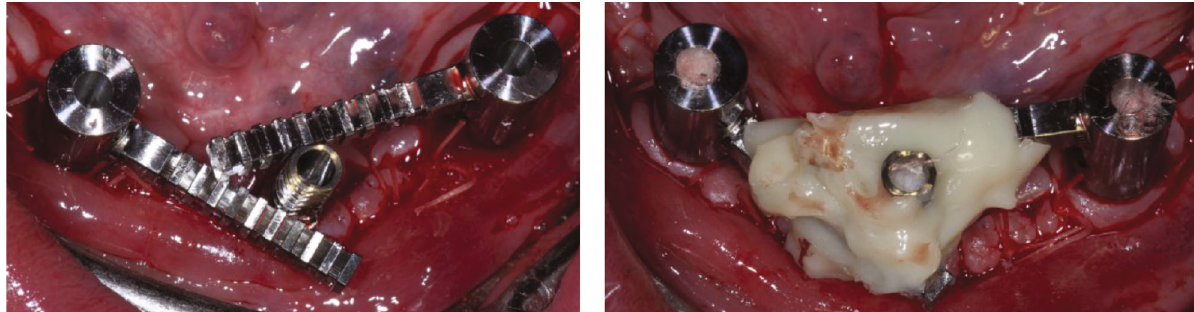
Figure 7: Three particularly designed transfers are screwed on the implants and splinted with composite.